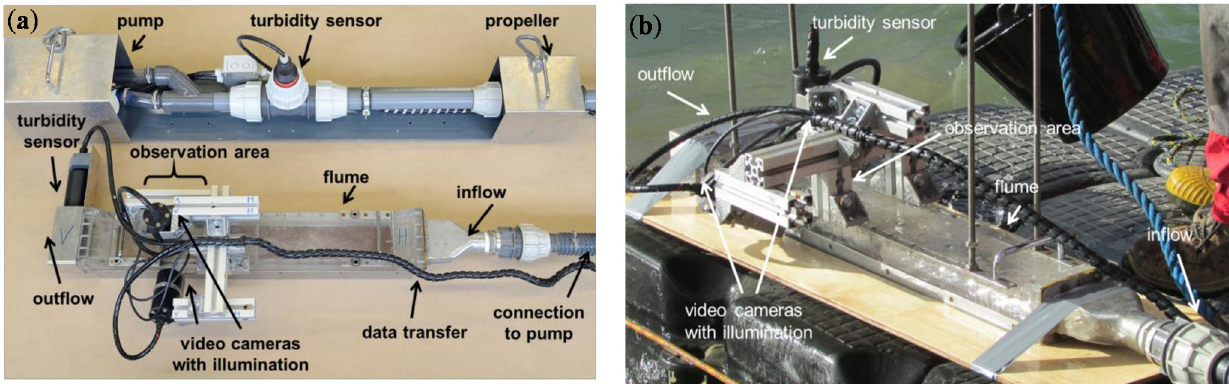
Figure 1. In situ device to determine critical bottom shear stresses at the sediment surface with submersible pump in the laboratory ( a ) and in the field with submerged pump ( b